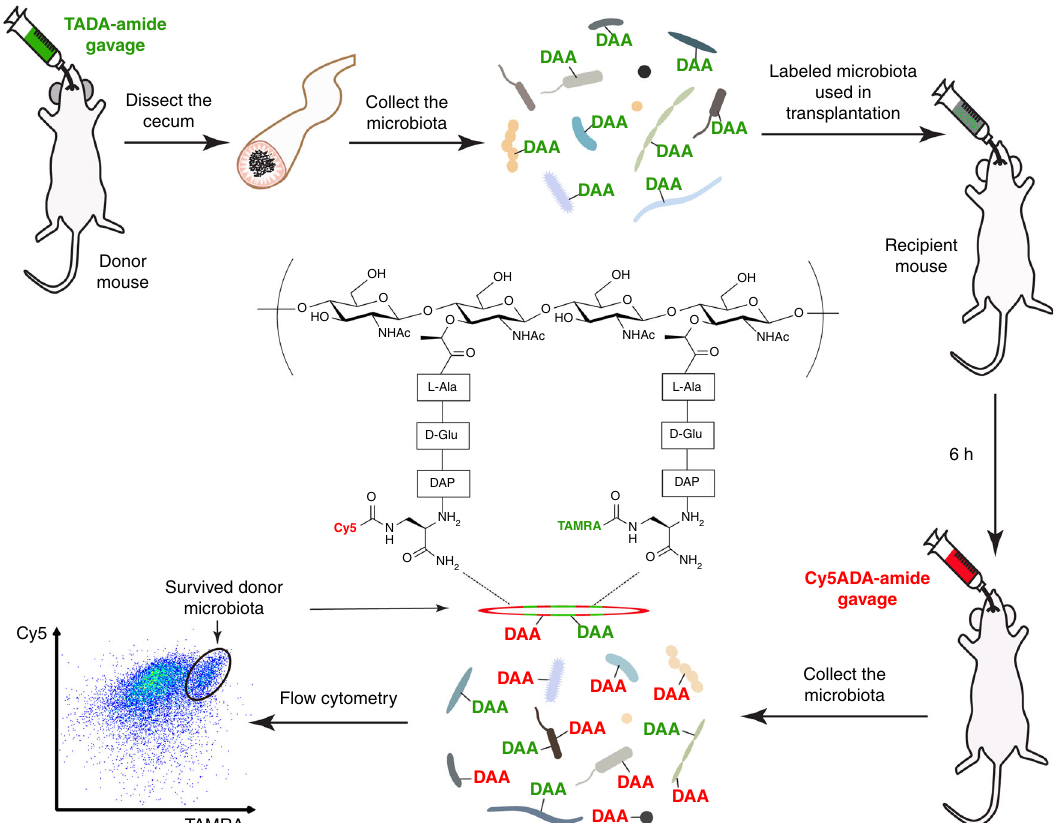
Fig. 1 STAMP for assessing the viability of transplanted gut microbiotas. The donor mouse gut microbiota labeled in vivo by the fi rst FDAA probe (TADA- amide) was intragastrically administered to the recipient mouse, which was then given a second FDAA probe (Cy5ADA-amide) by gavage 6 h after the transplantation. The recipient ’ s gut microbiota was collected, and analyzed by two-color fl uorescence microscopy and fl ow cytometry. The bacteria labeled by both probes were the transplants that survived in the recipient ’ s gut, bacteria labeled with only TAMRA were probably those did not survive during transplantation, and bacteria labeled only by Cy5 were the recipient ’ s original gut